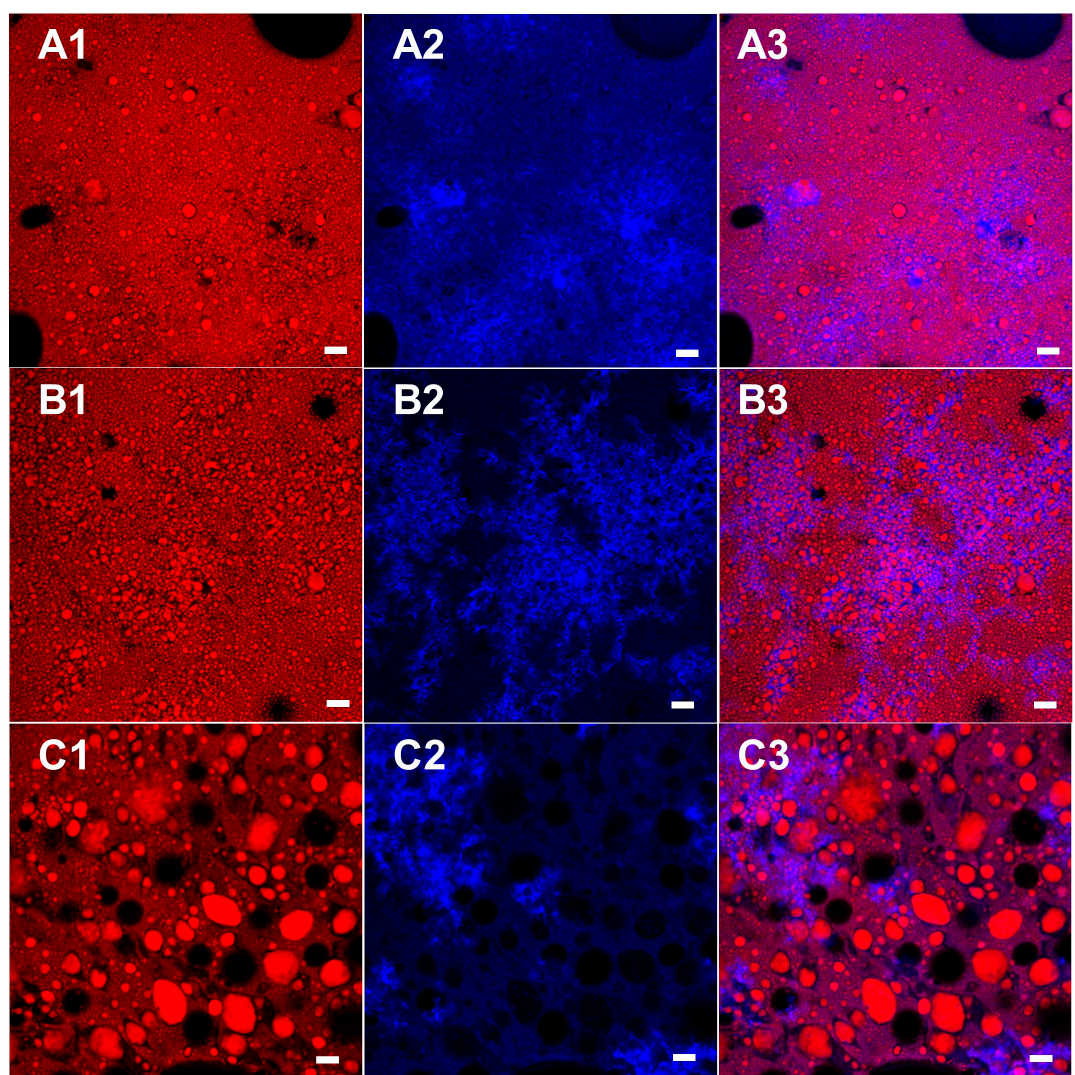
Figure 5. Confocal micrograph obtained for bigel samples using 20 × objective (A) H1; (B) H2; and (C) H3 stained with Nile red (oil phase) and Nile blue A (gelatin in the water phase). (1) Oil phase, (2) water phase, and (3) combined image of both phases. Bar = 20 µm.